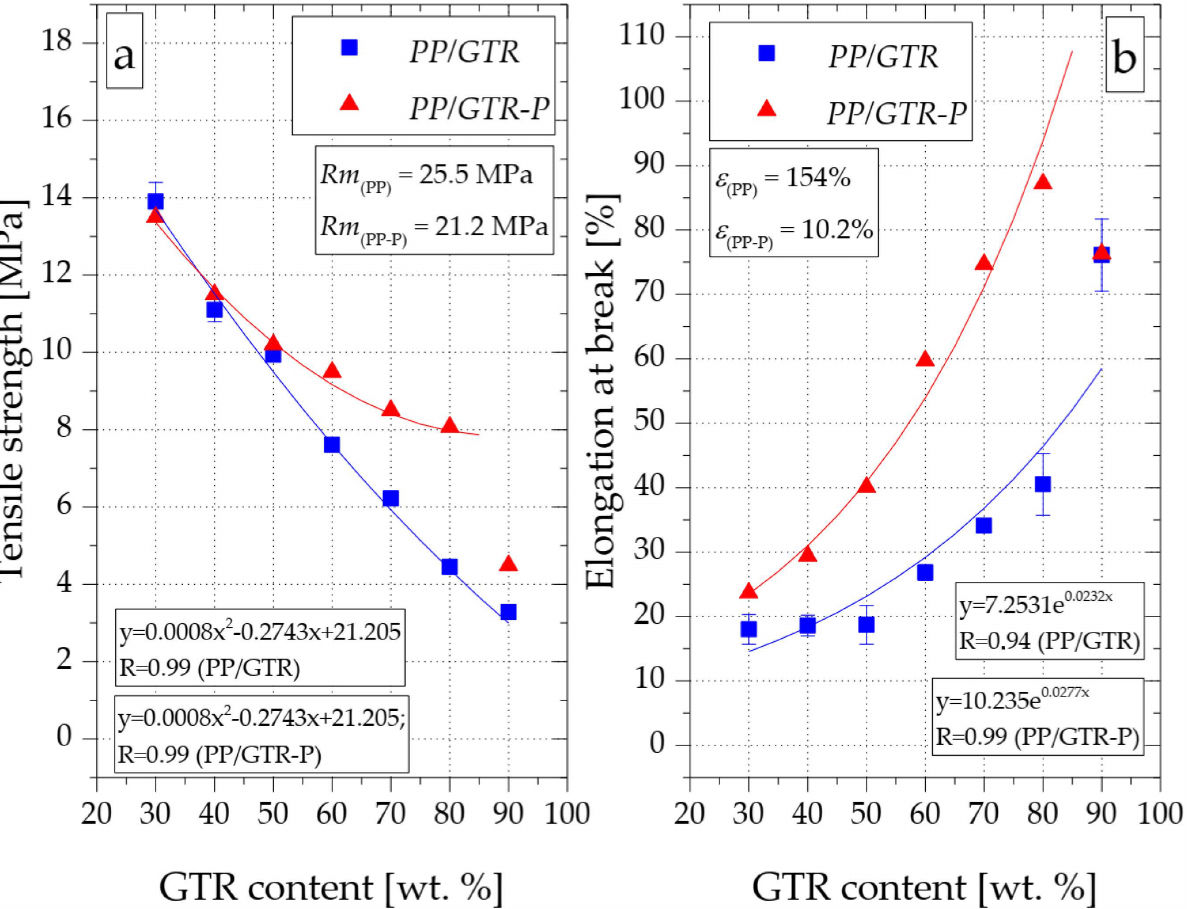
Figure 15. Influence of GTR content on tensile strength ( a ) and elongation at break ( b ) of PP/GTR